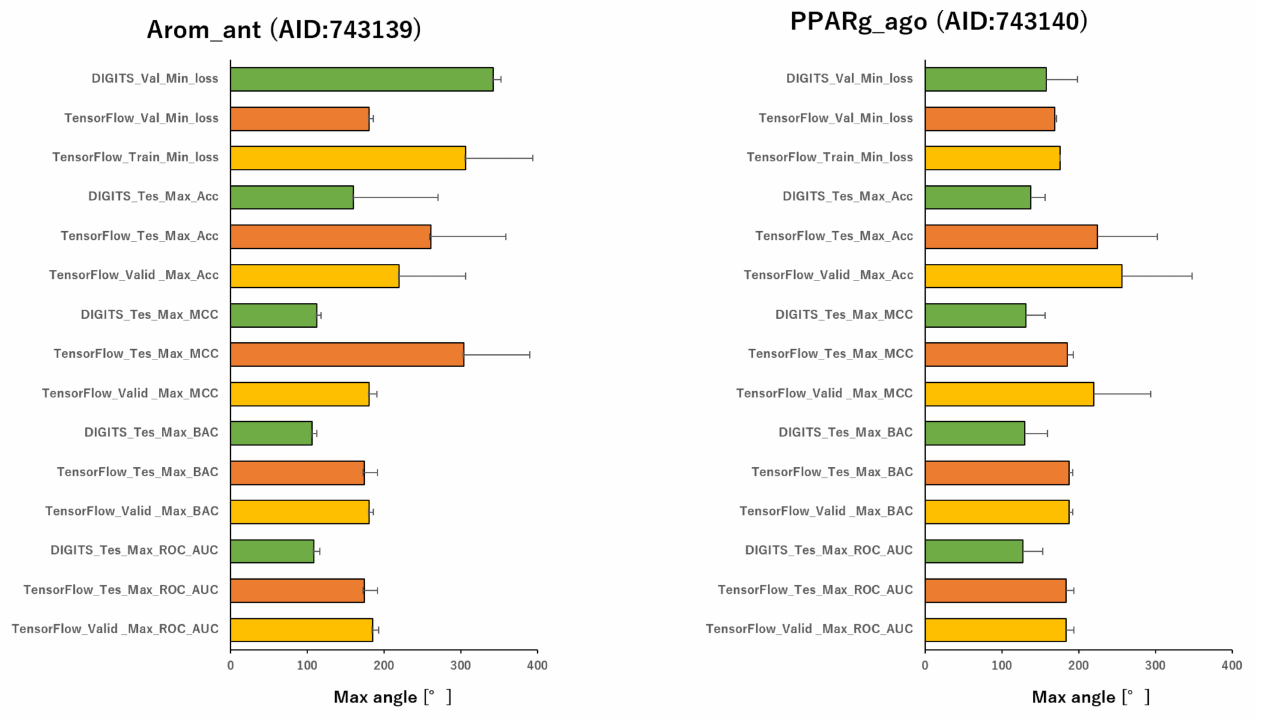
Figure 7. Means angles of max_ROC_AUC, max_BAC, max_MCC, max_Acc, min_loss of Arom_ant (AID:743139) and PPARg_ago